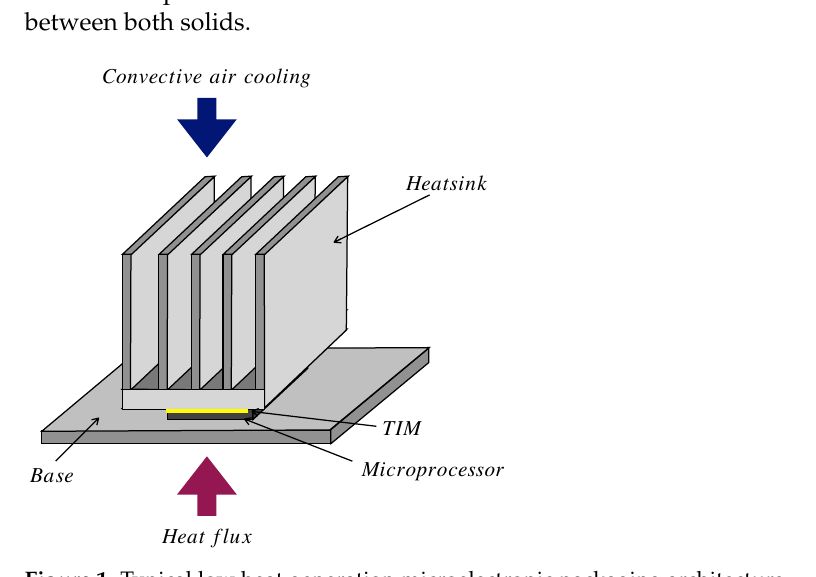
Figure 1. Typical low heat generation microelectronic packaging